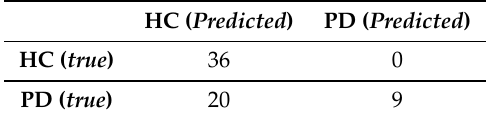
Table 7. Confusion matrix for the ensemble of all tasks.